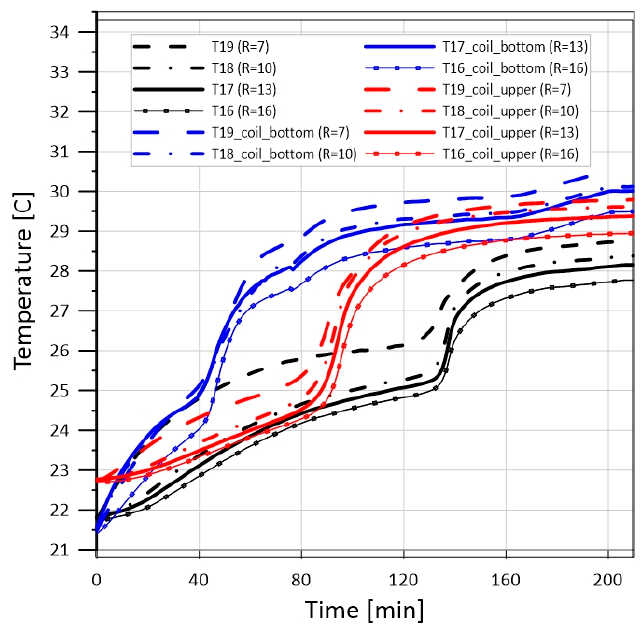
Figure 16. Temperature vs. time for increasing the radial position during the melting process with constant wall temperature condition ( Ts = 34 °C) on surface S5 .